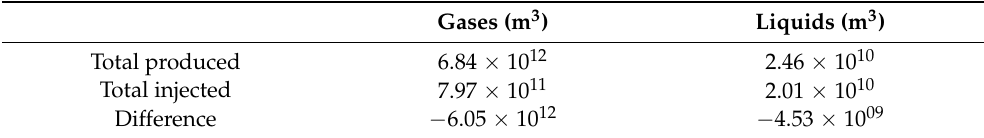
Table 1. Summary of calculated industrial fluid injection and production stock-tank volumes in the Alberta Basin (1960–2020). Source data extracted from geoLOGIC Systems databases © 2020.